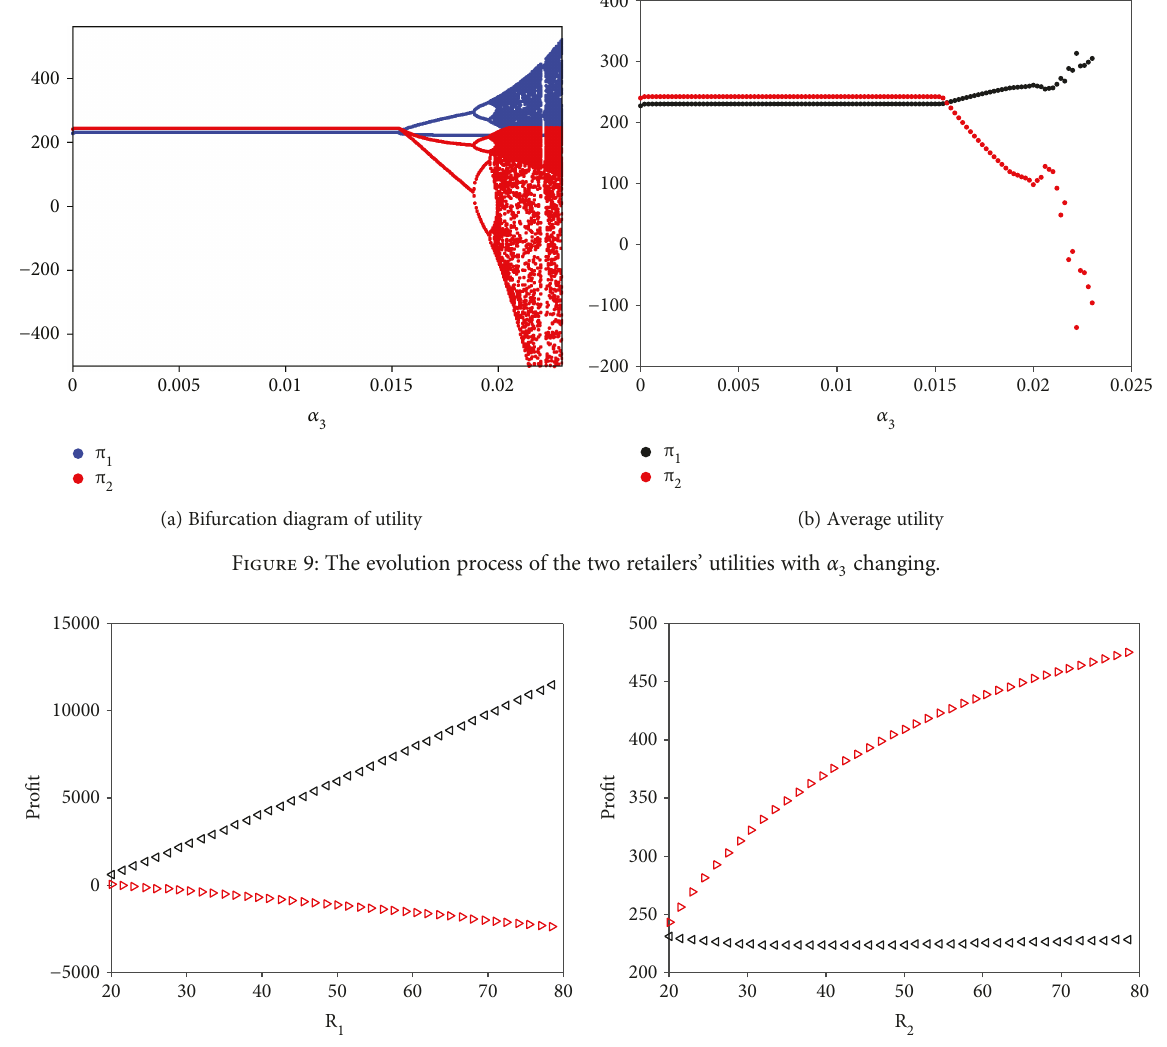
Figure 10: The in fl uence of risk-aversion level on the utilities of the two